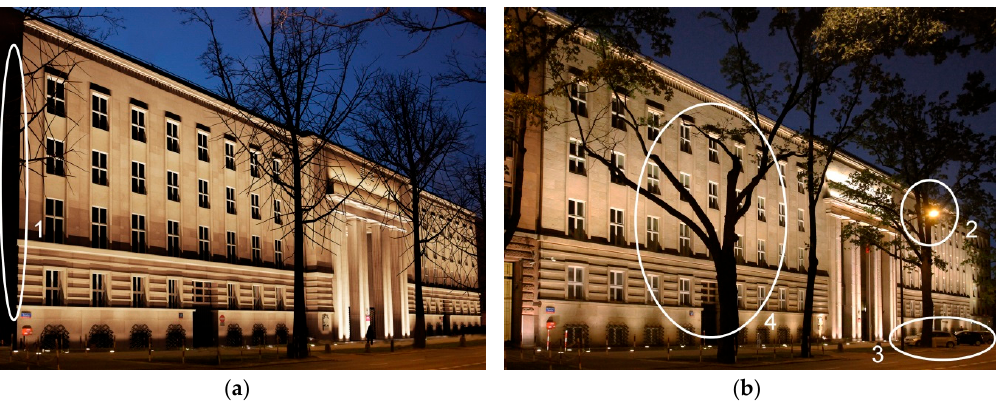
Figure 9. Image details which resulted in making correct identification of: ( a ) visualisation and ( b ) photo of analysed object. 1—no adjacent building; 2—street lamp; 3—parked cars; 4—unnatural appearance of tree.